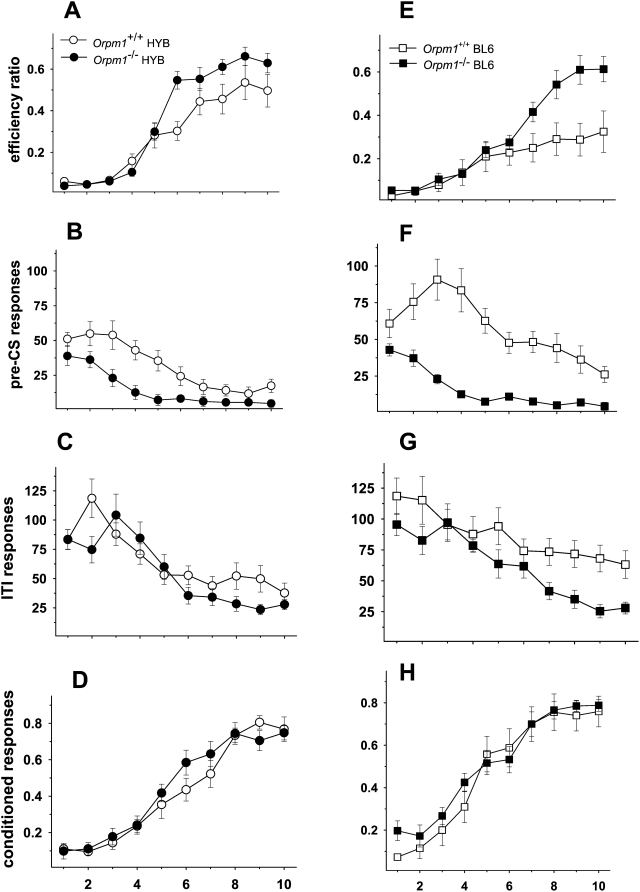

Oprm1
−/− mice perform better in the signaled nose poke task.Performance on Phase 4 of the signaled nose poke task for mu-opioid receptor knockout mice and their wild-type controls on a HYB (A–D) and BL6 (E–H) backgrounds. A and E: Efficiency ratios (rewards/nose pokes) increased across sessions with Oprm1 −/− mice on both genetic backgrounds performing significantly better than wild-type controls. Mice lacking the Oprm1 gene exhibited lower levels of responding throughout Phase 4 testing; this phenotypic difference was most apparent during the pre-CS period (Fig. 2B and 2F), when animals must learn to inhibit responding in order to maximize the number of rewards earned. C and G: Responses on the rewarded side during the 20-s inter-trial interval (ITI) decreased across sessions with lower overall responses in the Oprm1−/− groups and in the HYB strain. D and H: Conditioned responding (rewards/signals) increased across sessions with no genotype or background differences. Oprm1
 +/+ HYB, n = 11; Oprm1
 +/+ BL6, n = 12; Oprm1
−/− HYB, n = 10; Oprm1
−/− BL6, n = 11.